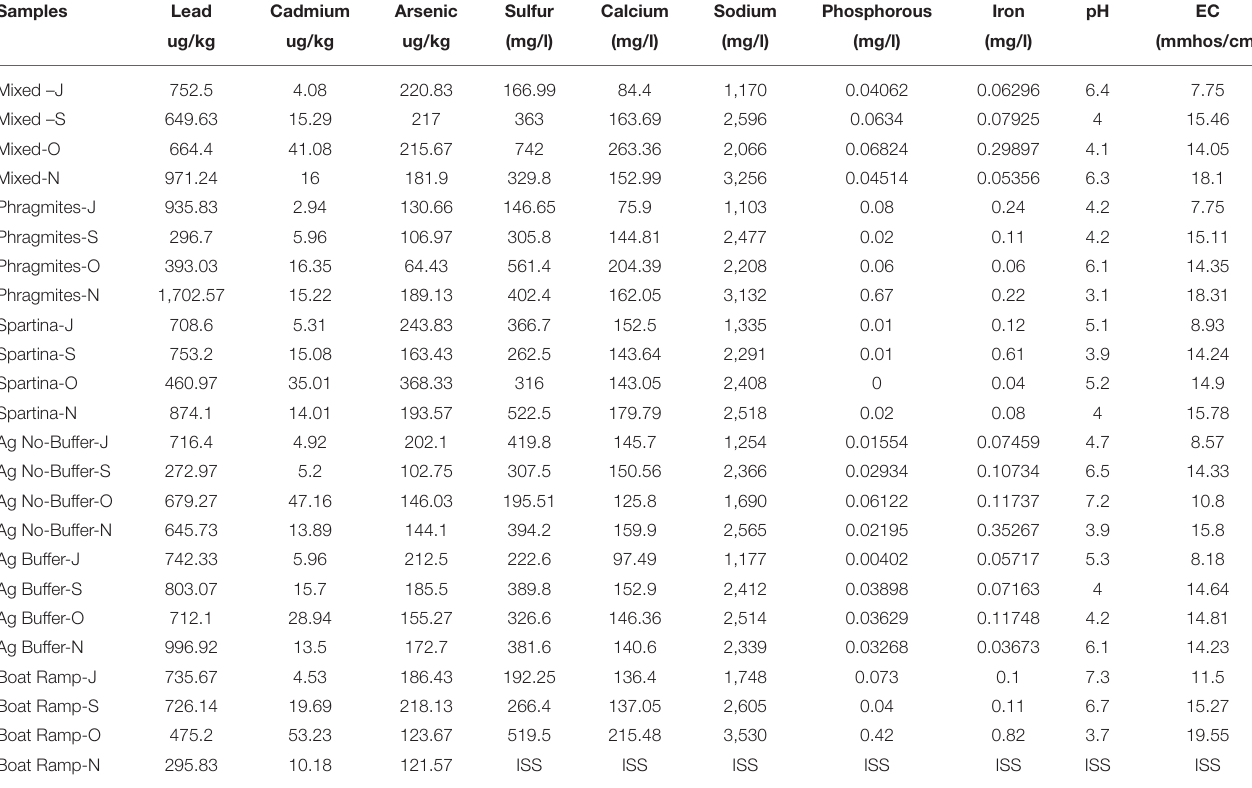
TABLE 2 | The concentrations of heavy metals and the ion compositions for the pore water samples in 2014.